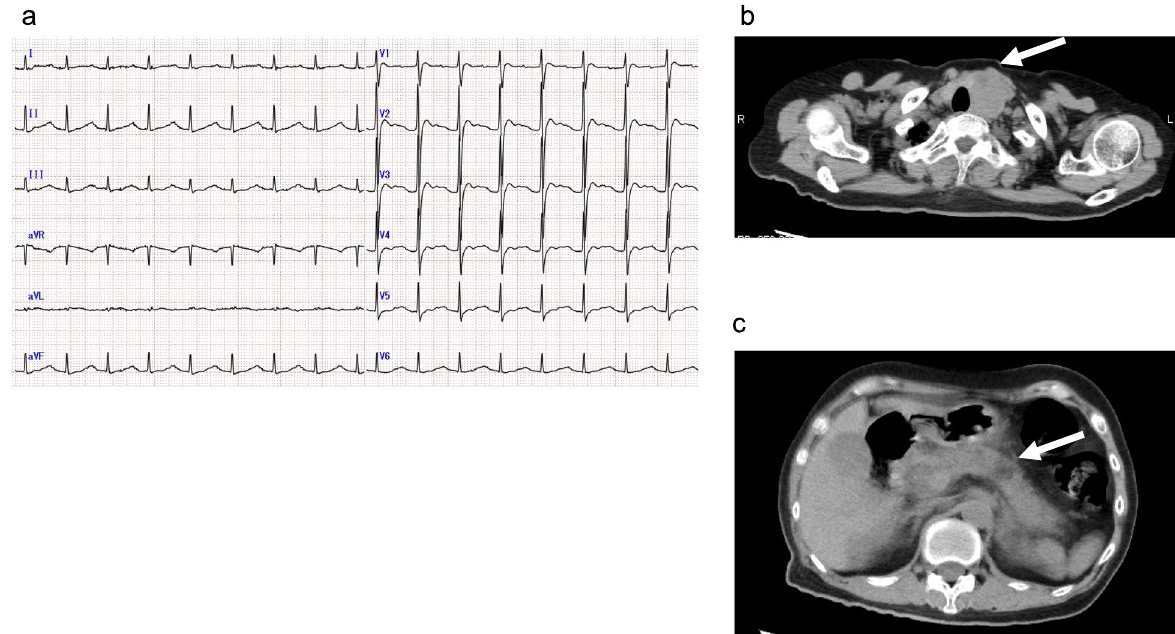
Fig. 1 Electrocardiogram ( a ) and neck and abdominal CT images ( b and c ) on admission. Electrocardiogram demonstrated marked QT prolongation (corrected QT interval, 695 ms) ( a ). CT images showed a 40